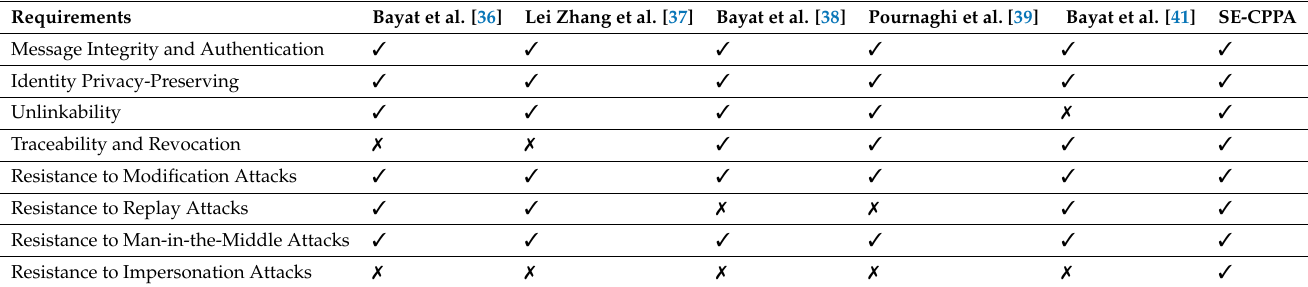
Table 2. Security analysis-based privacy